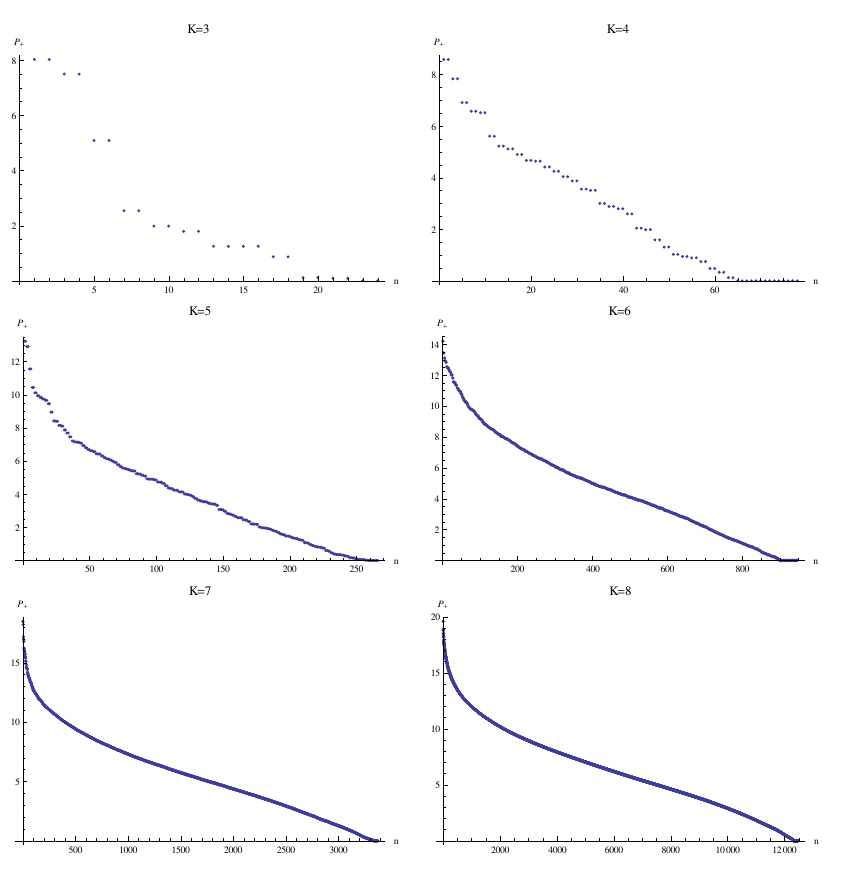
Figure 14 . DLCQ spectrum of N = (0 ; 2) SQCD with N 1 = N 2 = N 3 and g = m . Each plot shows the ordered eigenvalues of P + in units of 2 g 2 N c . (The energy density of states (cid:26) ( E ) is minus the inverse derivative).